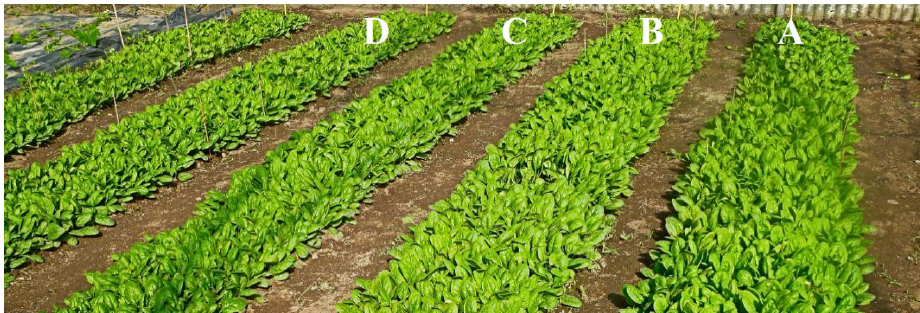
Figure 1. Spinach plots in the experimental trial ( A = legume-derived protein hydrolysate; B = extract of seaweed Ecklonia maxima ; C = control; D = mixture of vegetal oils, herbal and seaweed Ascophyllum nodosum extracts).